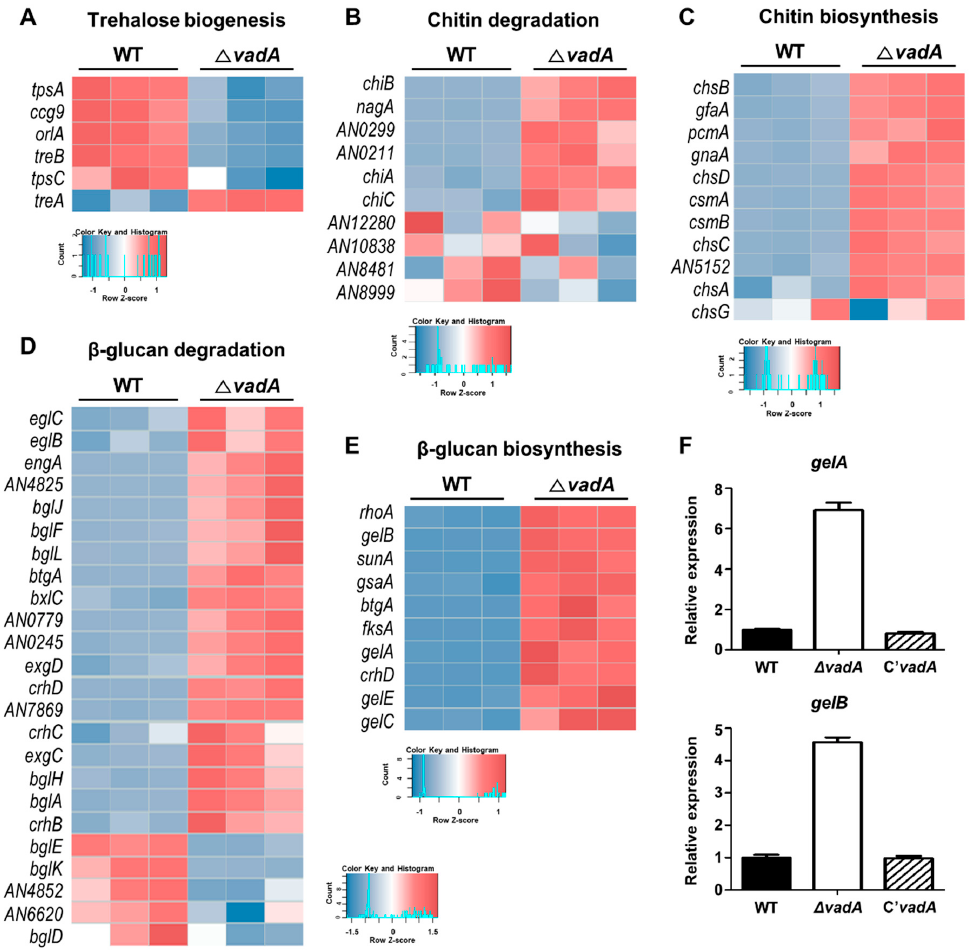
Figure 2. mRNA expression of cell-wall integrity-related genes in Δ vadA conidia. ( A – E ) Heat map showing the differentially expressed genes (DEGs) of trehalose biogenesis ( A ), chitin degradation ( B ), chitin biosynthesis ( C ), β -glucan degradation and β -glucan biosynthesis ( C ) in control and Δ vadA conidia. ( F ) mRNA expression of gelA and gelB in control (THS30), Δ vadA (THS33), and C’ vadA (THS34) conidia were assessed by qRT-PCR. Error bars indicates the standard errors from the mean of